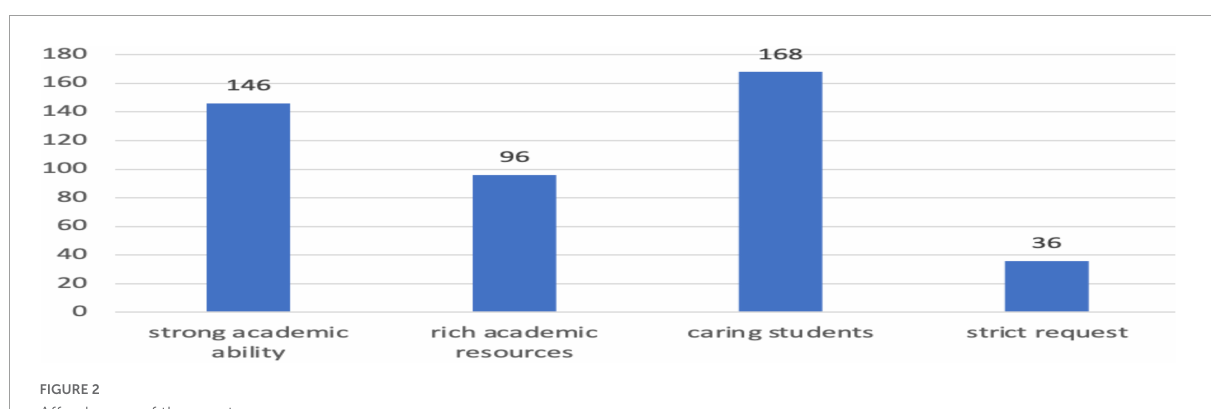
FIGURE2 Affordances of the mentor.